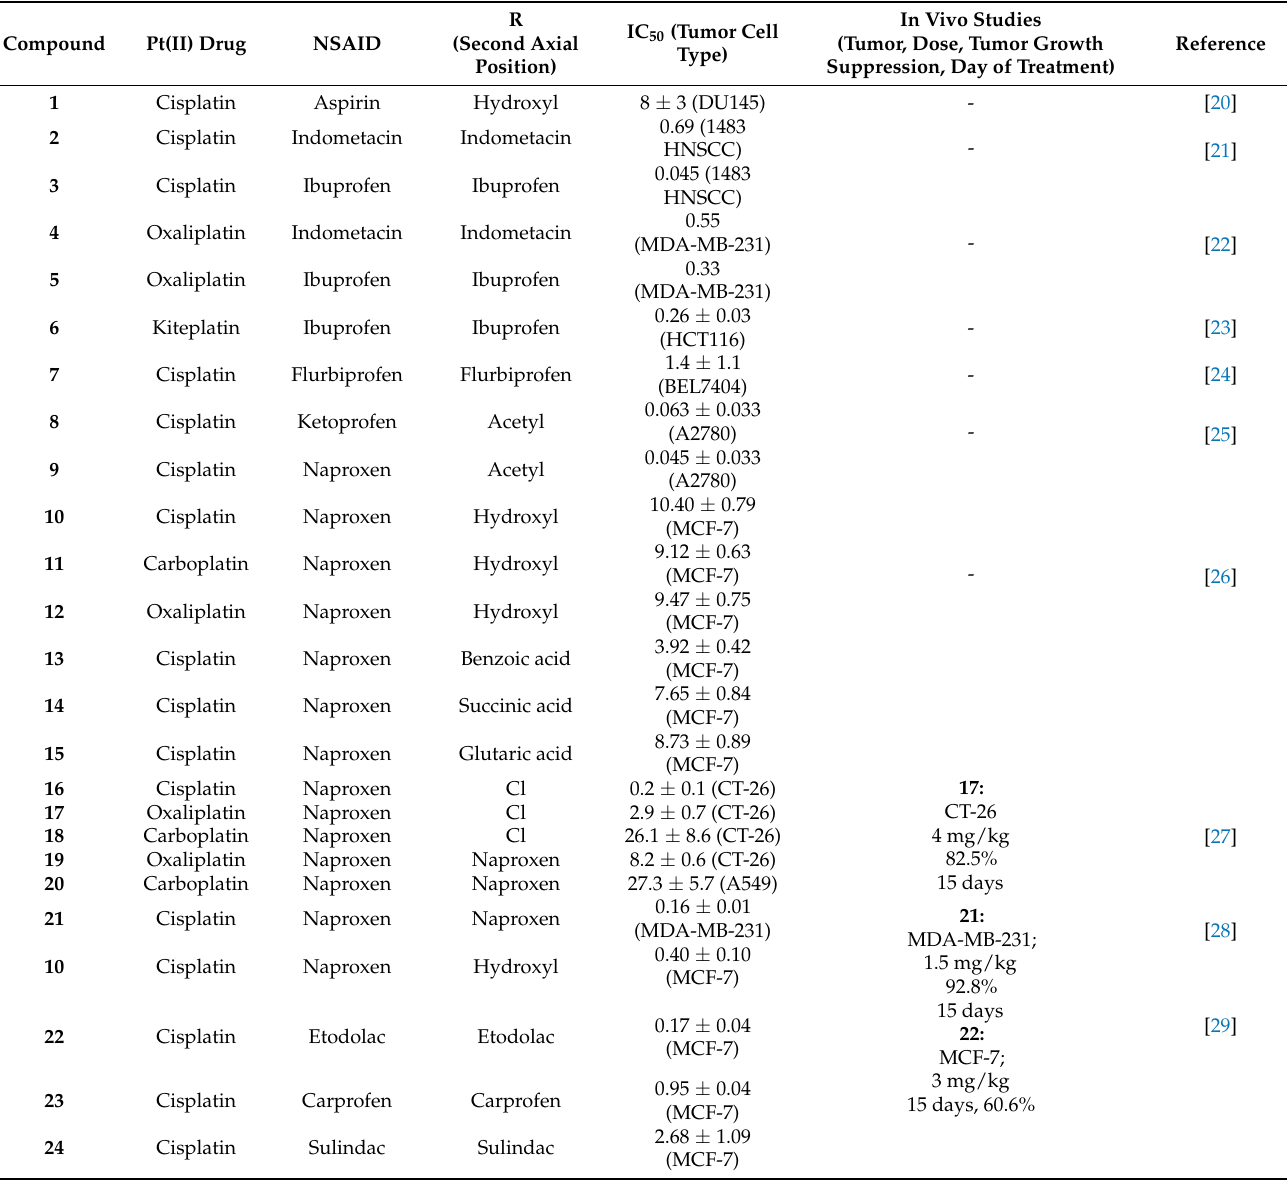
Table 1. Dual action platinum(IV) prodrugs with NSAIDs as axial ligand(s). DU145—androgen independent human prostate adenocarcinoma cells; HNSCC—Head and neck squamous cell carcinoma; MDA-MB-231—triple negative human breast adenocarcinoma; HCT-116—human colon carcinoma; BEL7404—human hepatoma cell line; A2780—human